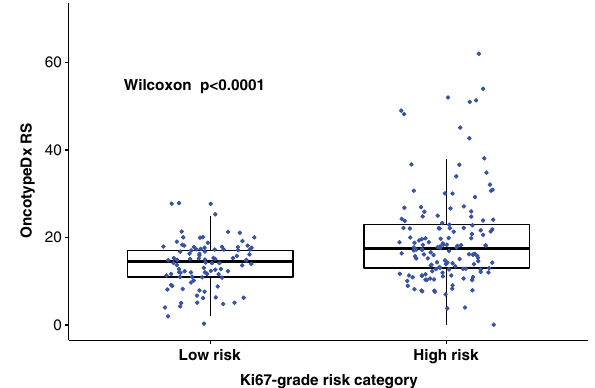
Fig. 3 OncotypeDx Recurrence Score (RS) according to Ki67-grade combined risk. Categories (low risk = grade 1 or Ki67 hotspot <20, high risk = rest). Box plot is drawn as follows: each box represents interquartile range with the inside line representing median value. Whiskers represent maximum (75th percentile + 1.5 × interquartile range) and minimum (25th percentile – 1.5 × interquartile range) values. Each dot represents individual